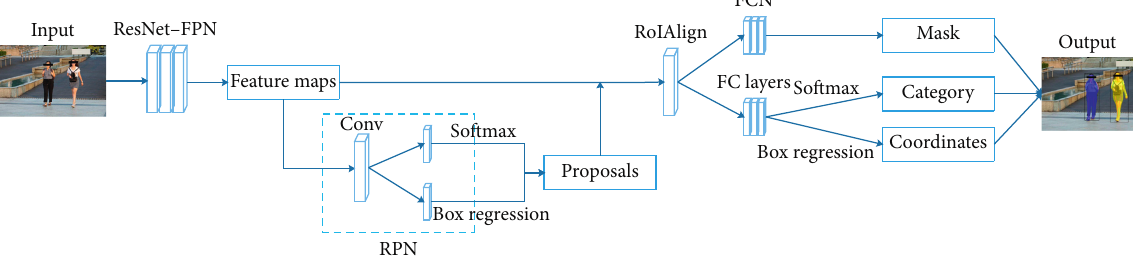
Figure 1: Mask R-CNN framework.